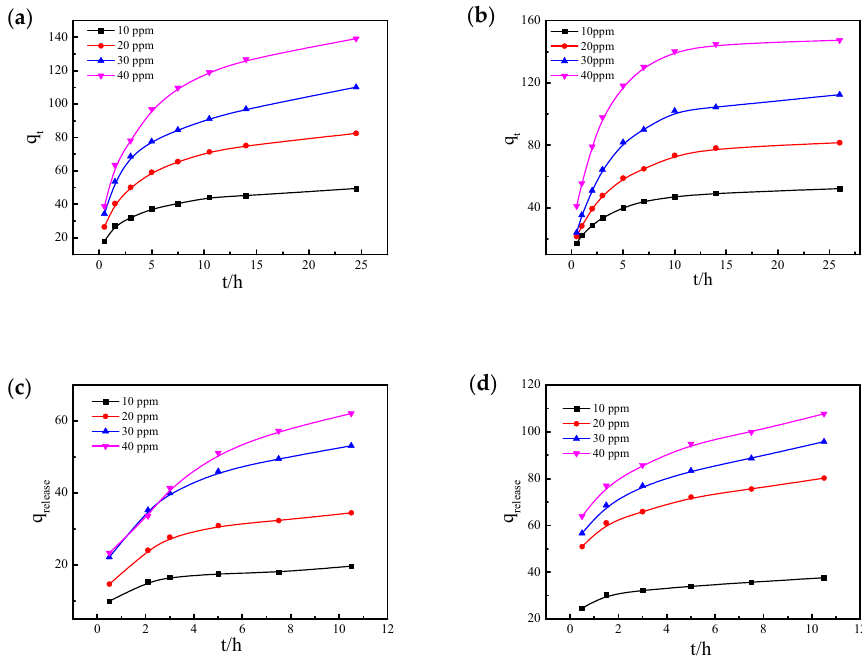
Figure 5. Adsorption kinetics of AO7 as a function of initial AO7 concentration using ( a ) Fe 3 O 4 @UiO-66 and ( b ) UiO-66; desorption kinetics of AO7 as a function of initial AO7 concentration using ( c ) Fe 3 O 4 @UiO-66 and ( d ) UiO-66.